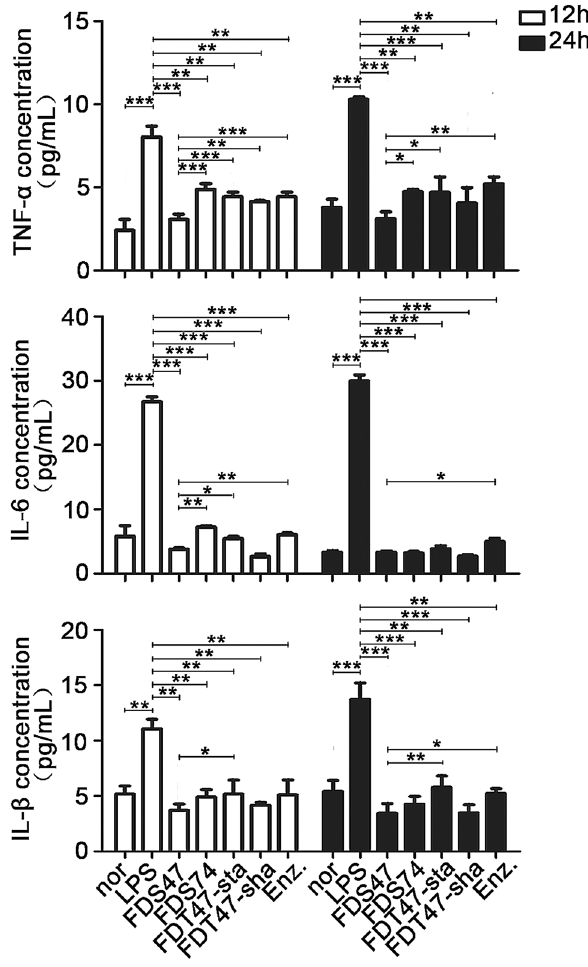
Figure 2. The levels of TNF-α, IL-6 and IL-1β in caco-2 cells after treated with different Danshen products. FDS47 (fermented Danshen sequence 47), FDS74 (fermented Danshen sequence 74), FDT47-sta (fermented Danshen together 47 shake), FDT47-sha (fermented Danshen together 47 stationary), Enz. (enzymolysis). TNF-α, IL-6 and IL-1β levels were examined in the supernatant of Caco-2 cells which were pretreated with 50 ug/mL LPS for 12 h, then treated with different Danshen products for 12 h or 24 h. All groups (Nor, FDS47, FDS74, FDT47-sta, FDT47-sha, Enz.) were statistically analyzed with the LPS group. Statistical analysis was conducted between FDS47 group and other groups (FDS74, FDT47-sta, FDT47-sha, Enz.). (Data are expressed as means ± S.E., * p < 0.05, ** p < 0.01 and *** p <